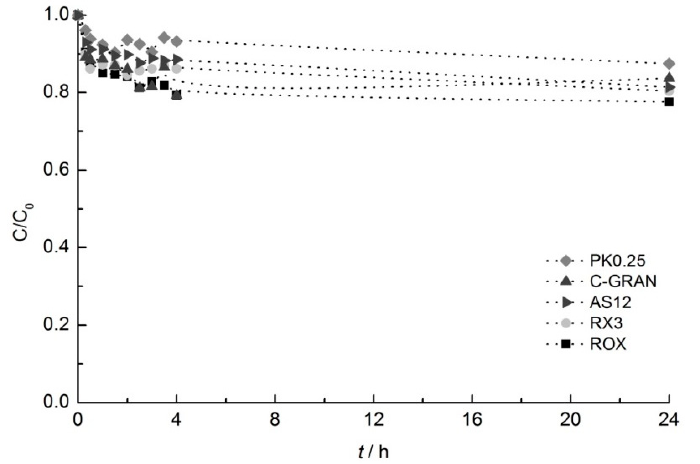
Figure 1. Phenol normalized concentration obtained as a function of time in adsorption runs performed with the commercial AC samples. Experiments performed with [phenol] = 4.5 g L − 1 , [adsorbent] = 2.5 g L − 1 , T = 353 K and pH = 3.5.